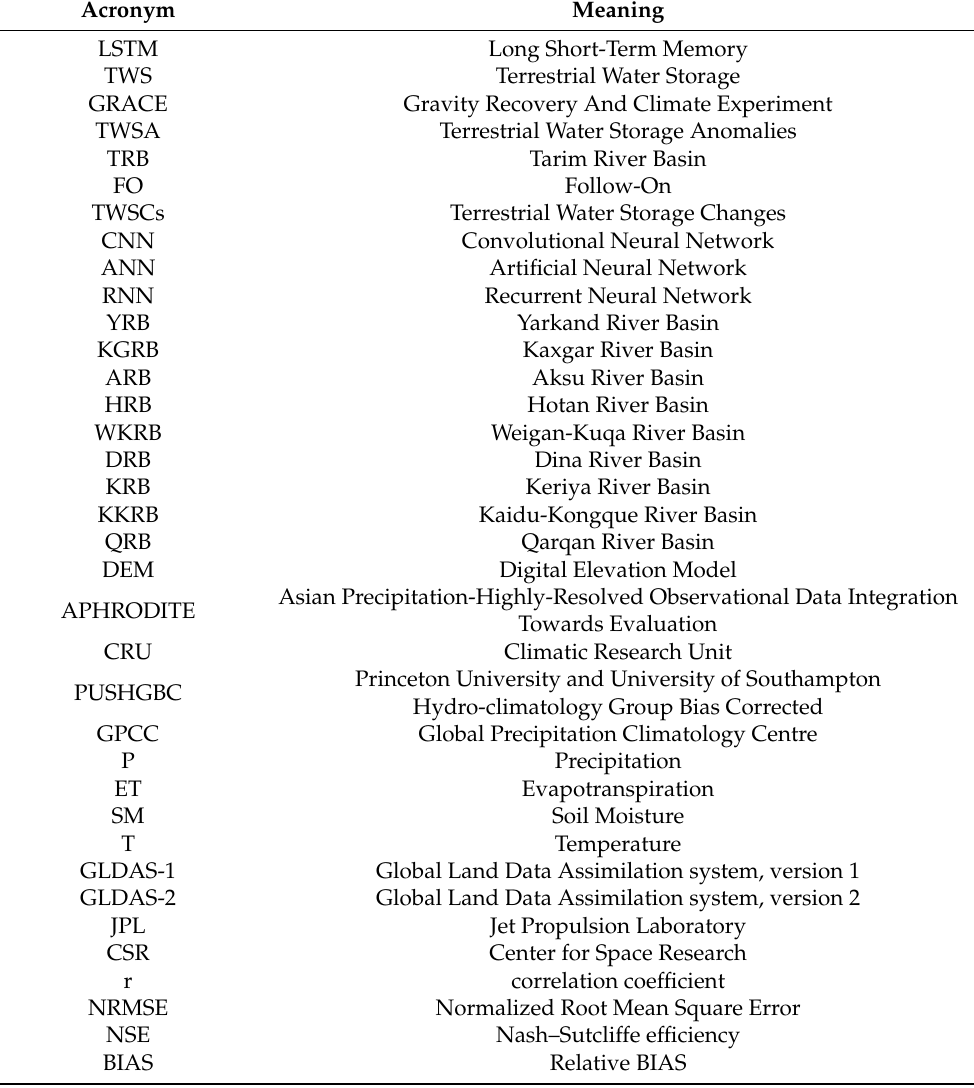
Table 1. List of acronyms used in this